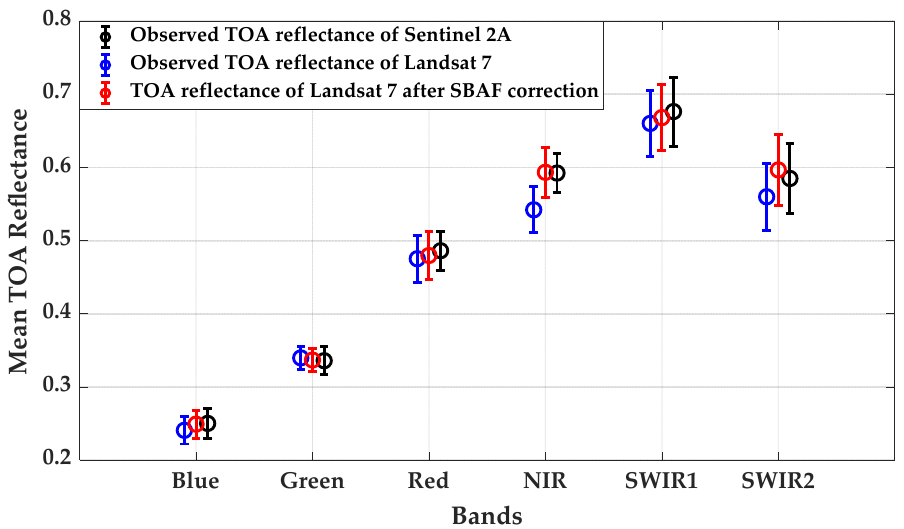
Figure 5. Comparison of TOA reflectance of Landsat 7 before and after the SBAF correction for the cross-calibration combination of Sentinel 2A and Landsat 7. (The error bars represent the standard deviation, k = 2).